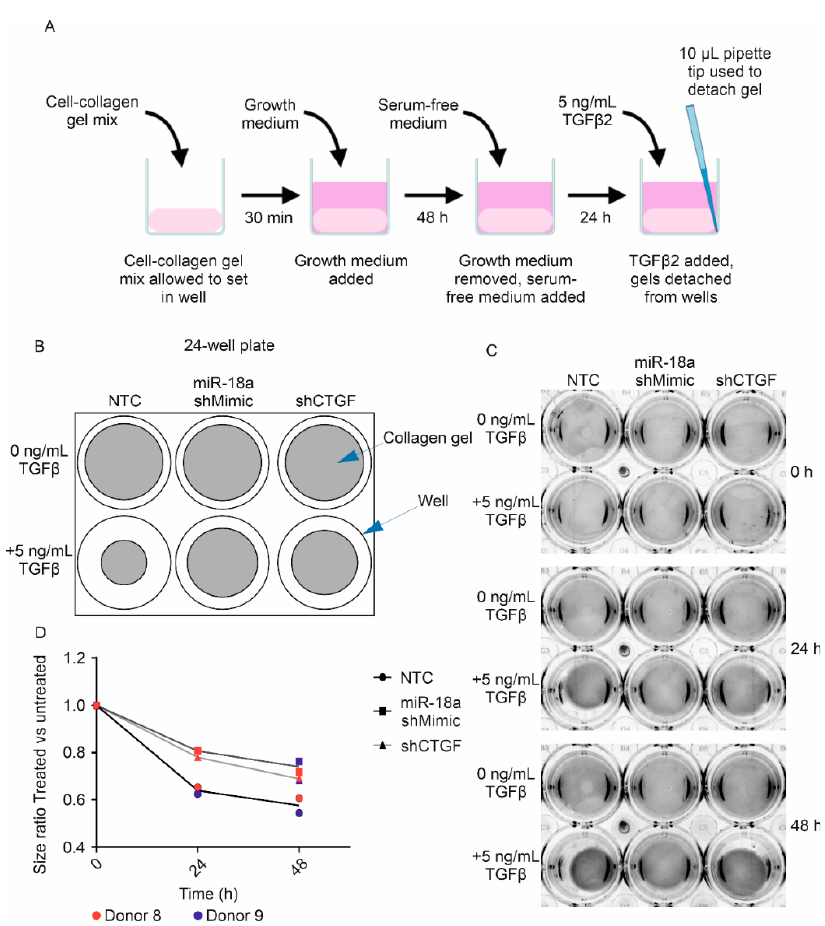
(shMIR-18a donor 8: 0.81-fold and donor 9: 0.81-fold). This was also the case for the cells expressing shCTGF (shCTGF donor 8: 0.78-fold and donor 9: 0.78-fold).